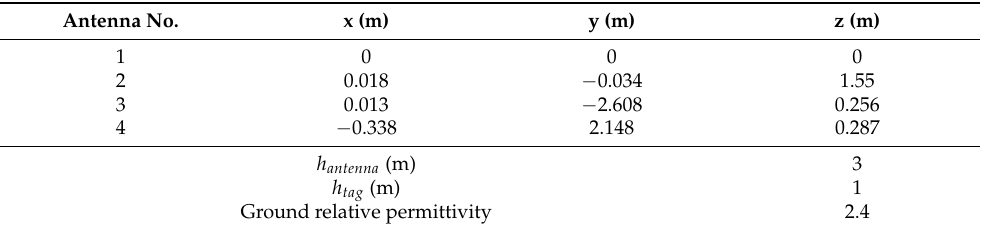
Table 1. (Up) Geometrical parameters for the positions of the four antennas in the Harmalière setup. (Down) Values of the main variables used in the two-ray model (see Figure 3); the height of the station is relative to the ground at the same